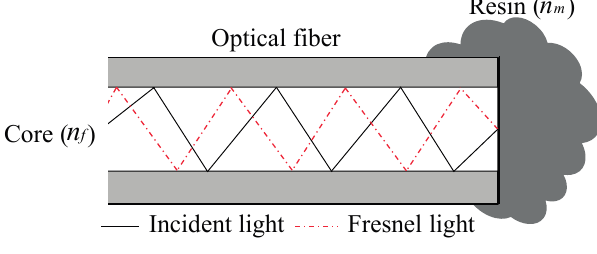
Figure 1. Fresnel reflection at fiber end/resin